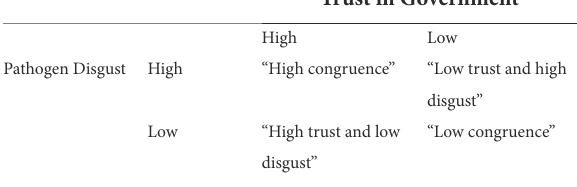
TABLE 1 A combination of pathogen disgust and trust in